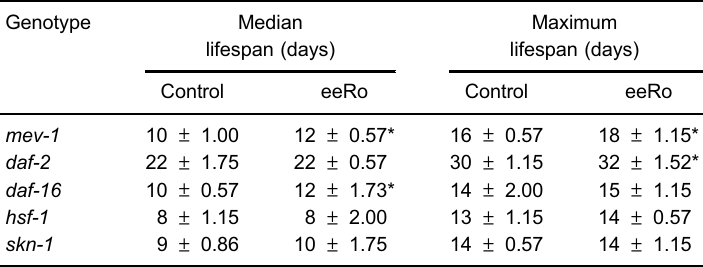
Table 2. Lifespan of mutant worms treated with 25 m g/mL